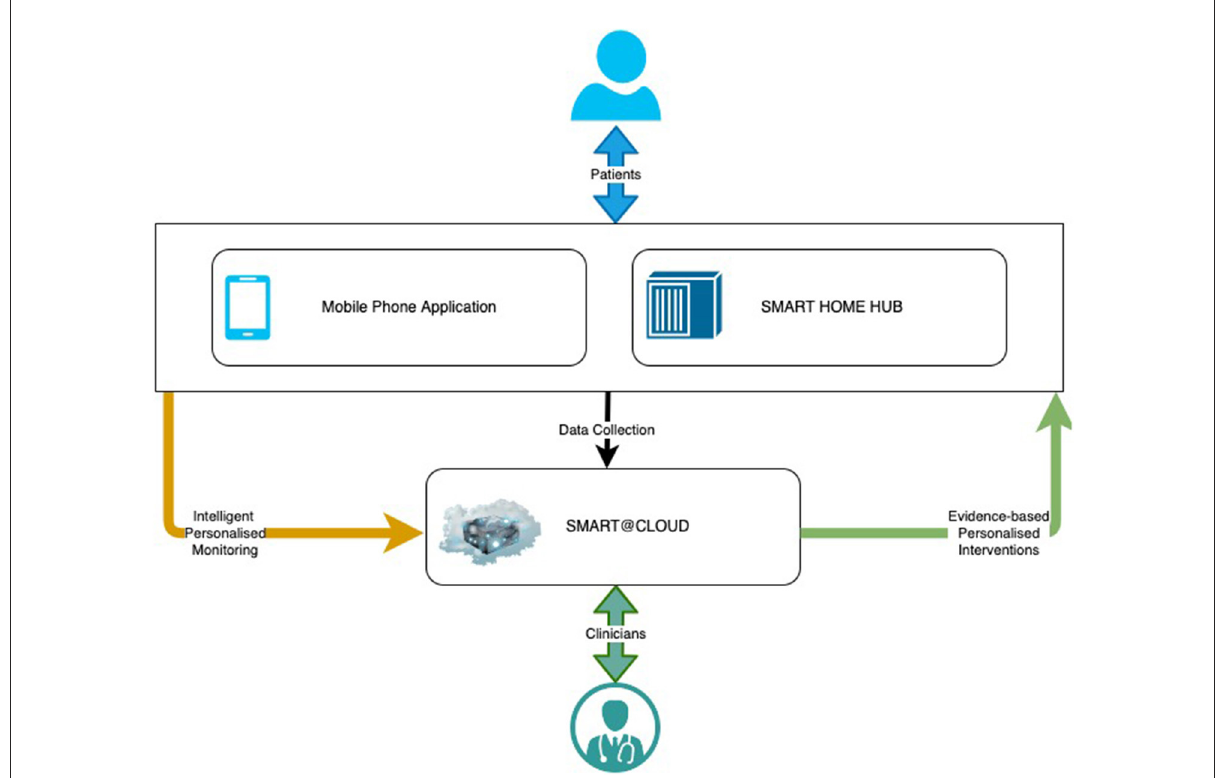
FIGURE3 The SMART BEAR